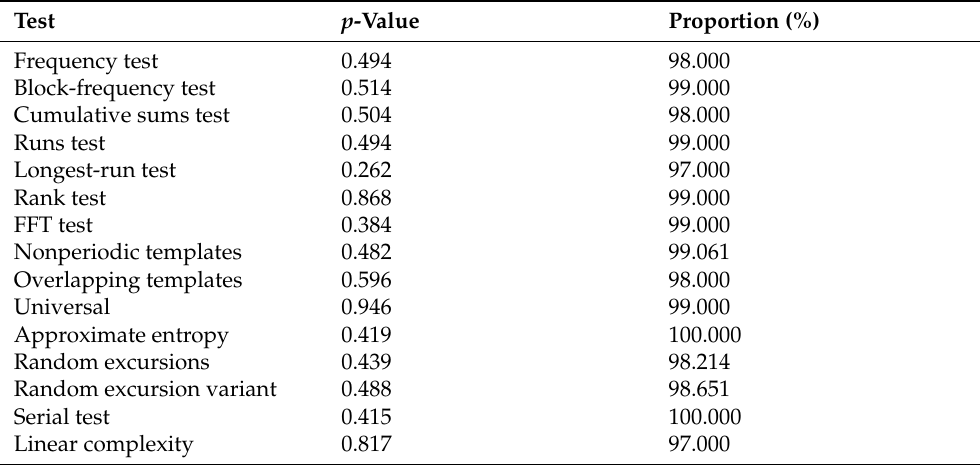
Table 5. P -values and proportion results of NIST tests.